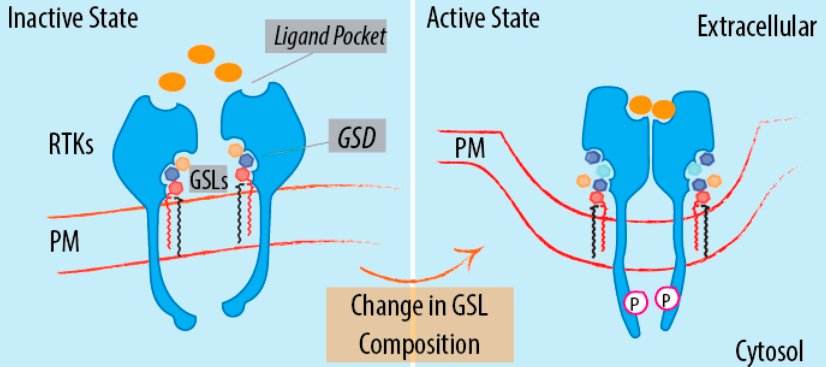
Figure 2. GSL influence on signalling. Schematic representation of the regulatory role of the GSLs on signal transduction. The regulation of RTKs by GSLs is provided as an example to illustrate the signalling role of GSLs. A specific GSL profile on plasma membrane can keep a RTK in an inactive state ( left panel ); A change in GSLs composition can regulate receptor activation/inactivation. GSLs act as allosteric regulators of receptor capability to recognize the ligand, to undergo multimerization and to auto-phosphorylate ( right panel ). GSLs, glycosphingolipids; Orange spheres represent ligands; Colored hexagons represent the different sugar residues of GSL-glycan moieties; Black-Red parallelogram, Cer backbone. Pink circle surrounding P represent phosphate groups; GSD, glycosphingolipid sensing domain; PM, plasma membrane; RTK, receptor tyrosine kinase.